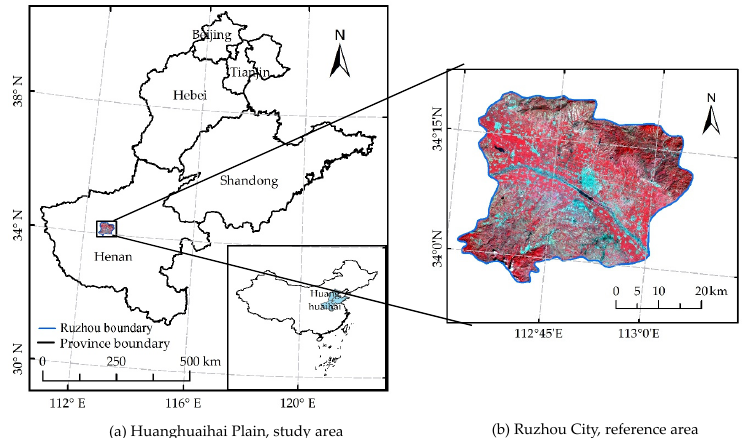
Figure 1. The spatial distribution of the study area ( a ) and reference area ( b